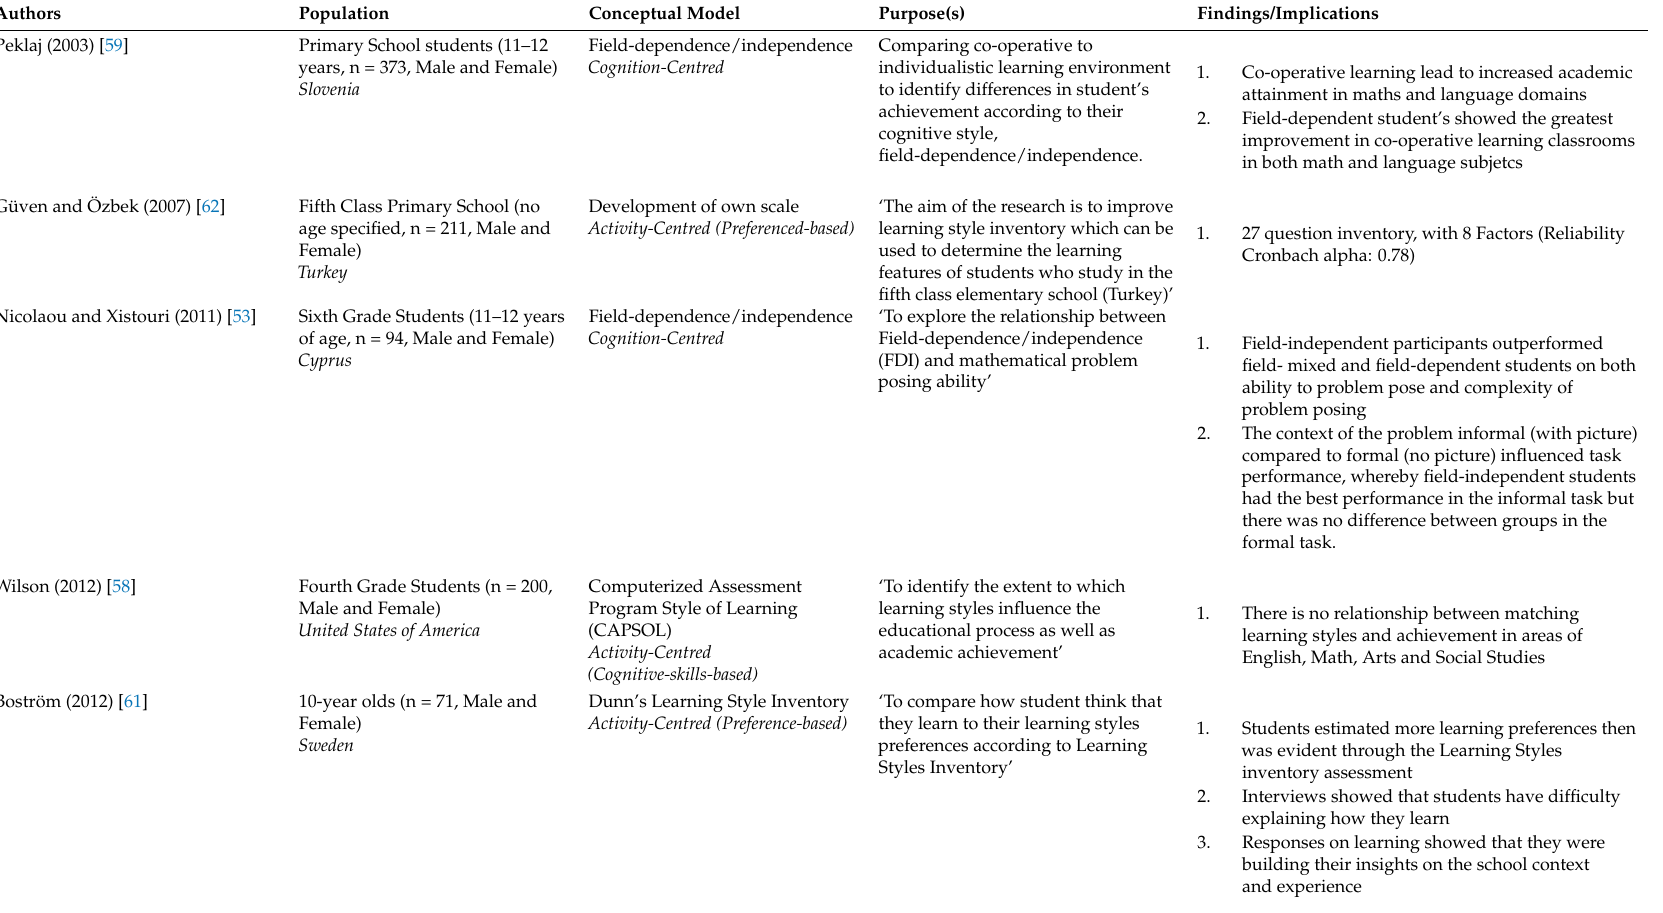
Table A1. Key Summary of